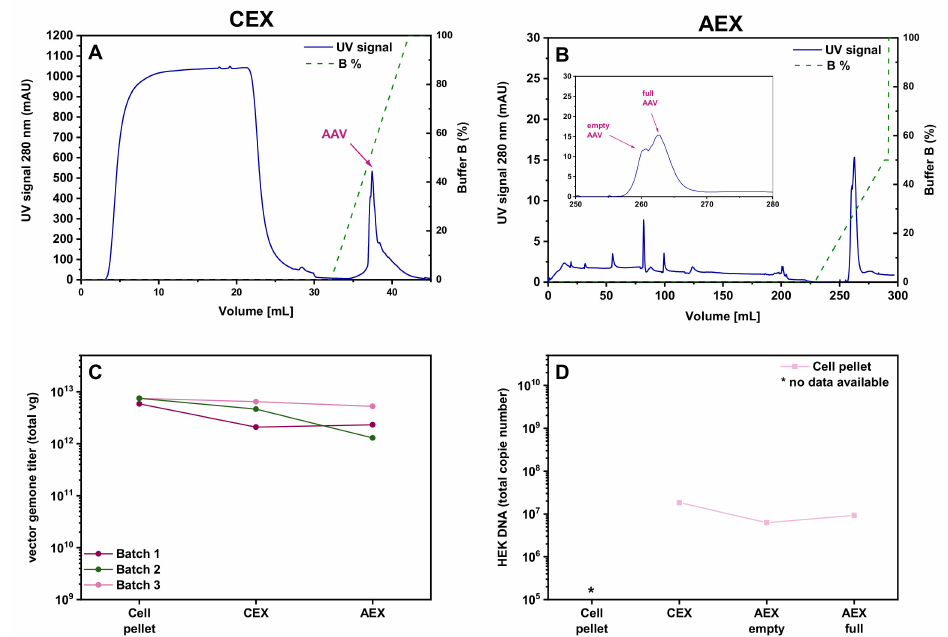
Figure 4. Purification of the rAAV2/8 vectors using the CEX-AEX process. ( A – C ) Chromatograms obtained with cell pellet materials in only two steps on the CEX ( A ) and AEX ( B ) columns. ( A ) CEX with a linear buffer B gradient. ( B ) AEX with a linear buffer B gradient. Magnification view of the AEX chromatogram shown in B. Each chromatogram shows the respective UV signal in blue (scale on the left Y -axis) and the concentration of buffer B depicted as a dashed green line (scale on the right). ( C ) Graph showing the yield (total vector genomes, vg) for the rAAV2/8 vectors obtained in CEX-AEX with the material harvested by lysis of the cell pellet. The residual HEK cell DNA amount is shown in ( D ). Due to matrix effects in the qPCR, the starting amount cannot be shown here. AAV, recombinant adeno-associated virus; AC, affinity chromatography; AEX, anion exchange chromatography; CEX, cation exchange